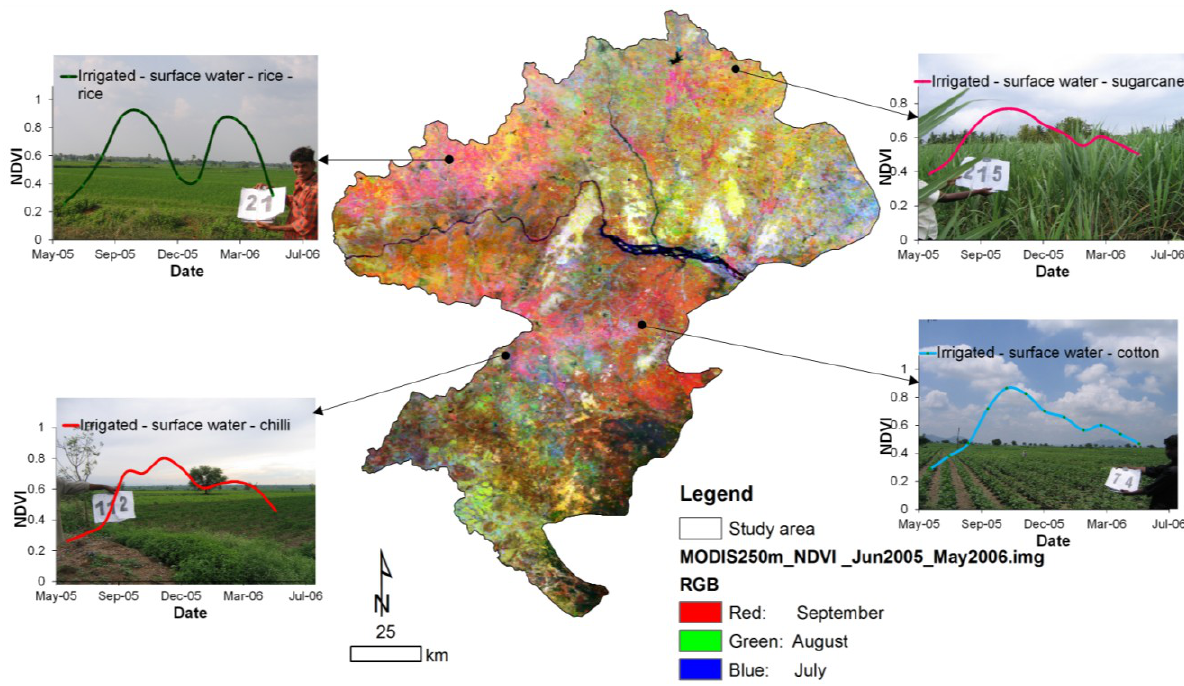
Figure 2. Ideal spectral signatures for different crops in the study area. Signatures were extracted from the precise knowledge of crop characteristics using a time series